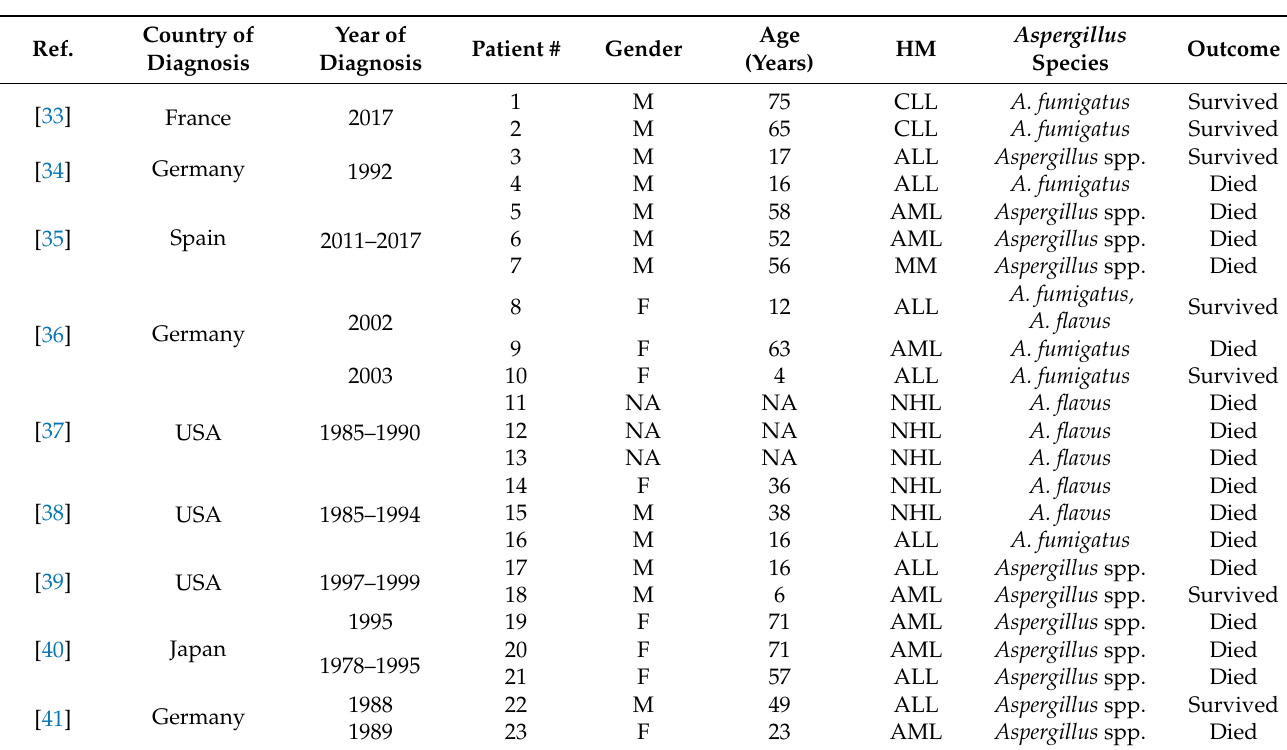
Figure 1. Prisma flow chart. Table 1. Characteristics of included